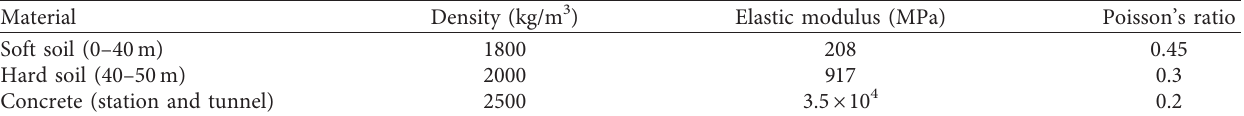
Table 1: Calculation parameters of each